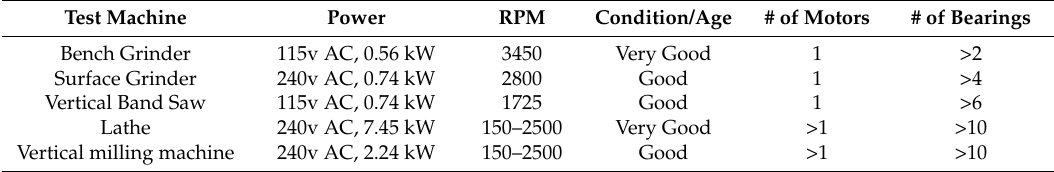
Figure 1. Test machines for acoustic emission: ( a ) bench grinder; ( b ) surface grinder; ( c ) vertical band saw; ( d ) lathe machine; and, ( e ) vertical milling machine. Table 1. Test machines’ specifications for acoustic emission (RPM—Revolution per minute).